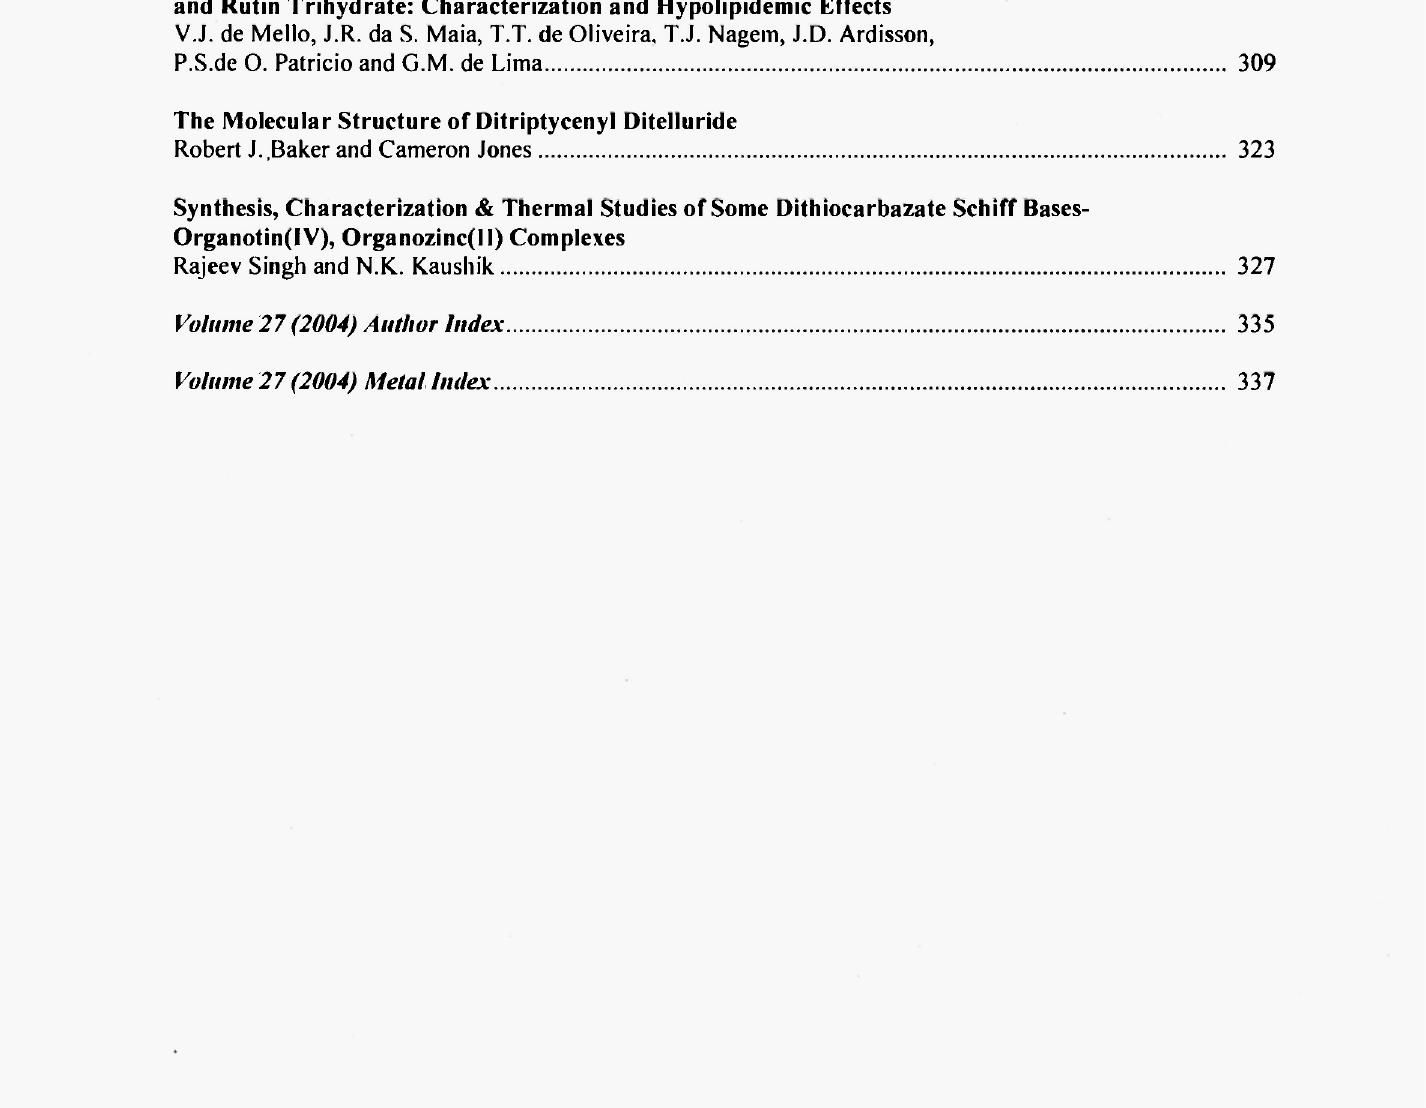
Synthesis and Structure of Organoaluminuin 0,C,0 Pincer Compounds Libor Dostal, Roman Jambor. Ales Ruzicka. Ivana Cisarova, Jaroslav Holecek 291 Some Applications of Germanium and its Derivatives Jacques Satge 301 Tin (IV) Compounds Derivatives of Reaction Between Organotin(IV), SNCLg and Rutin Trihydrate: Characterization and Hypolipidemic Effects